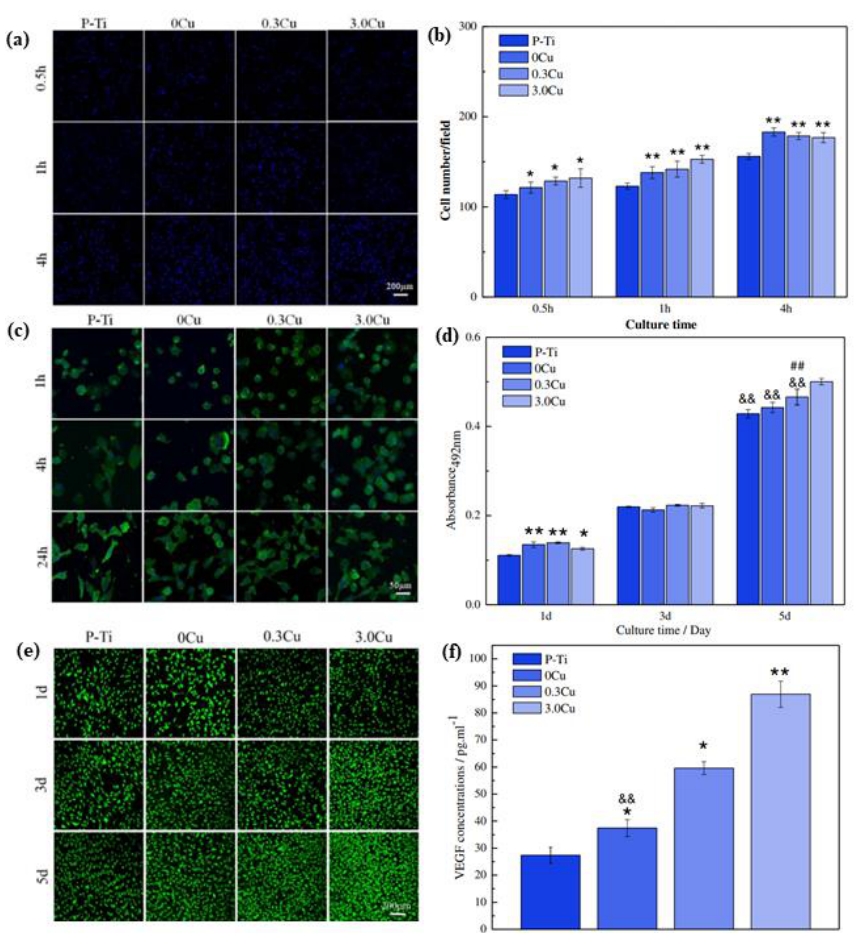
Figure 7. Response of endothelial cells: ( a ) fluorescence images and ( b ) quantitative results of cell adhesion; ( c ) fluorescence images of endothelial cells cultured on the MAO coatings with F-actins stained with FITC (green) and nuclei stained with DAPI (blue); ( d ) fluorescence images of live/dead staining of endothelial cells on the MAO coatings; ( e ) MTT results of endothelial cells on the MAO coatings; and ( f ) VEGF concentrations secreted by endothelial cells. **: p < 0.01 compared to P-Ti, ##: p < 0.01 compared to 0 Cu, &&: p < 0.01 compared to 3.0 Cu, *: p < 0.05 compared to P-Ti. Reproduced with permission from Ref. [34]. Copyright 2018,